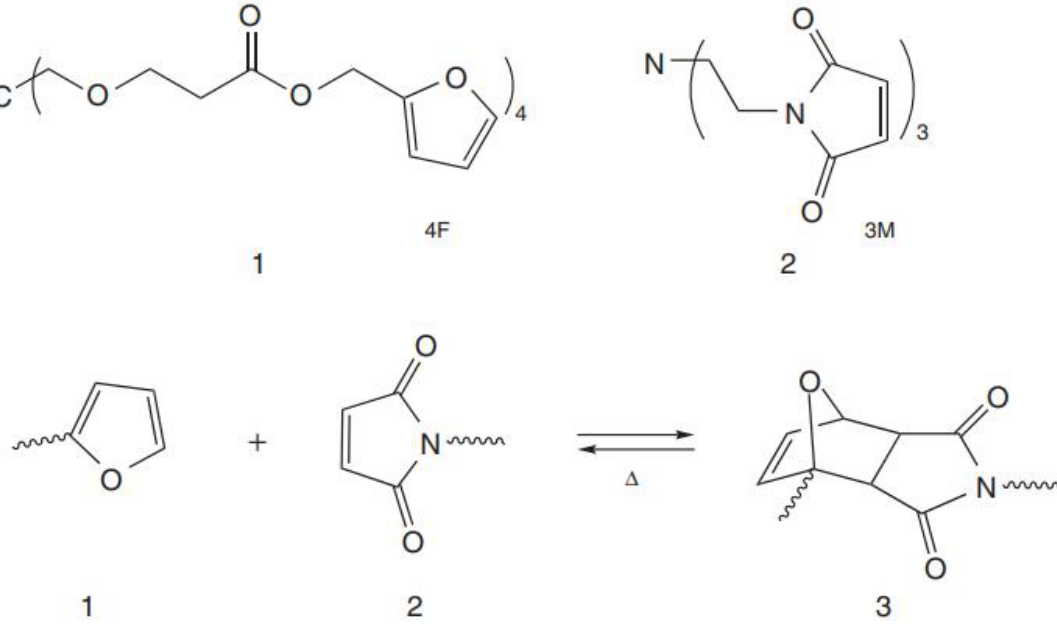
Figure 5. Schematic representation of highly cross-linked polymer [3M4F] formed by DA reaction using monomer 1 as multi-diene (4furan moieties 4F) and monomer 2 as multi-dienophile (3M) [55]